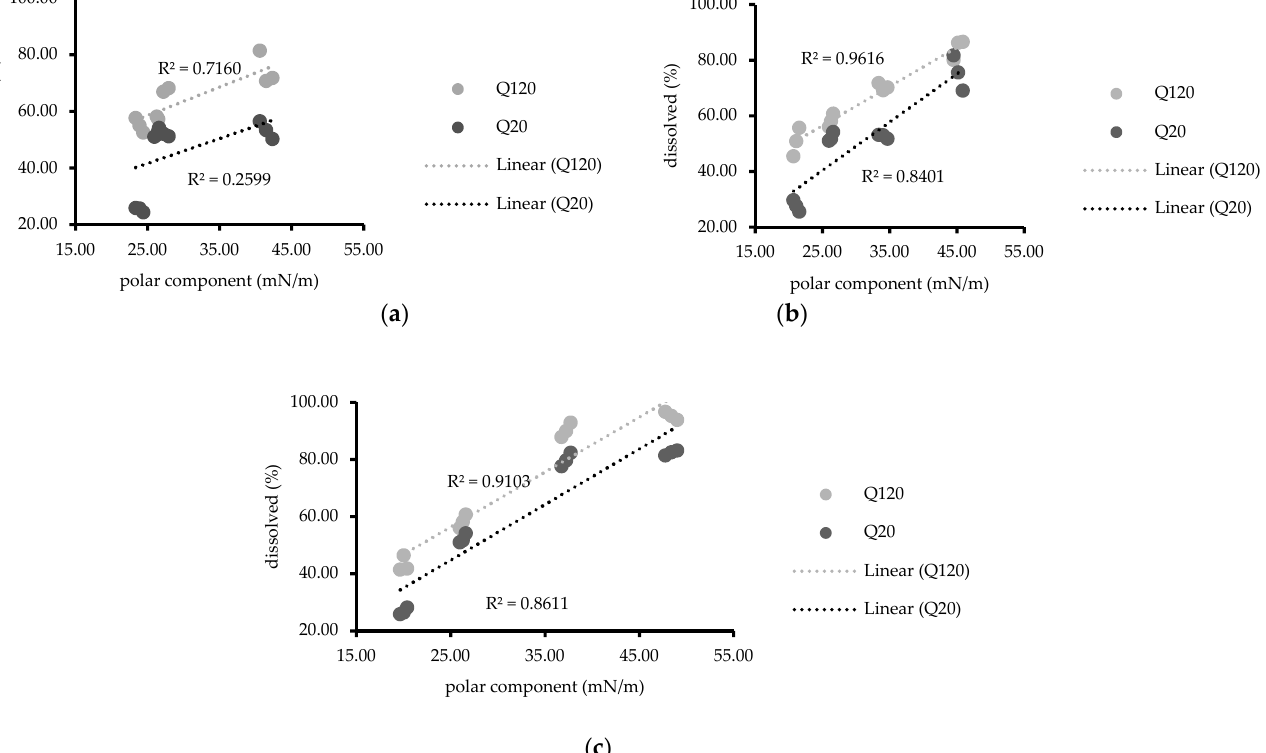
Figure 8. Illustrates the percentage of cellular uptake of NDP powder, SS, and PS20-06 after expo- sure with each formulation for 6 h (n = 3).